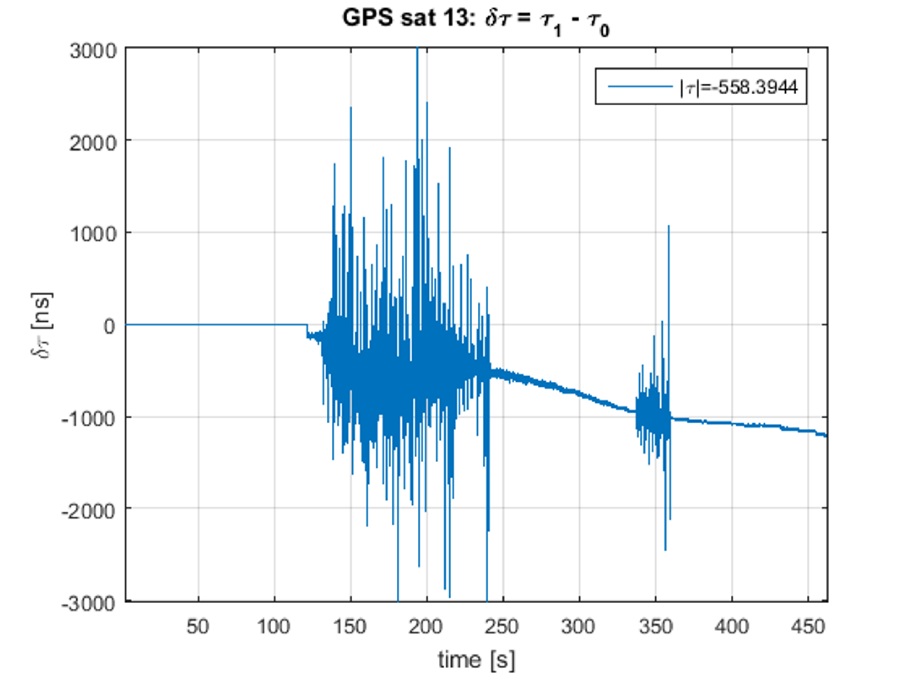
Figure 14. Delay difference estimation for satellite13, using TEXBAT